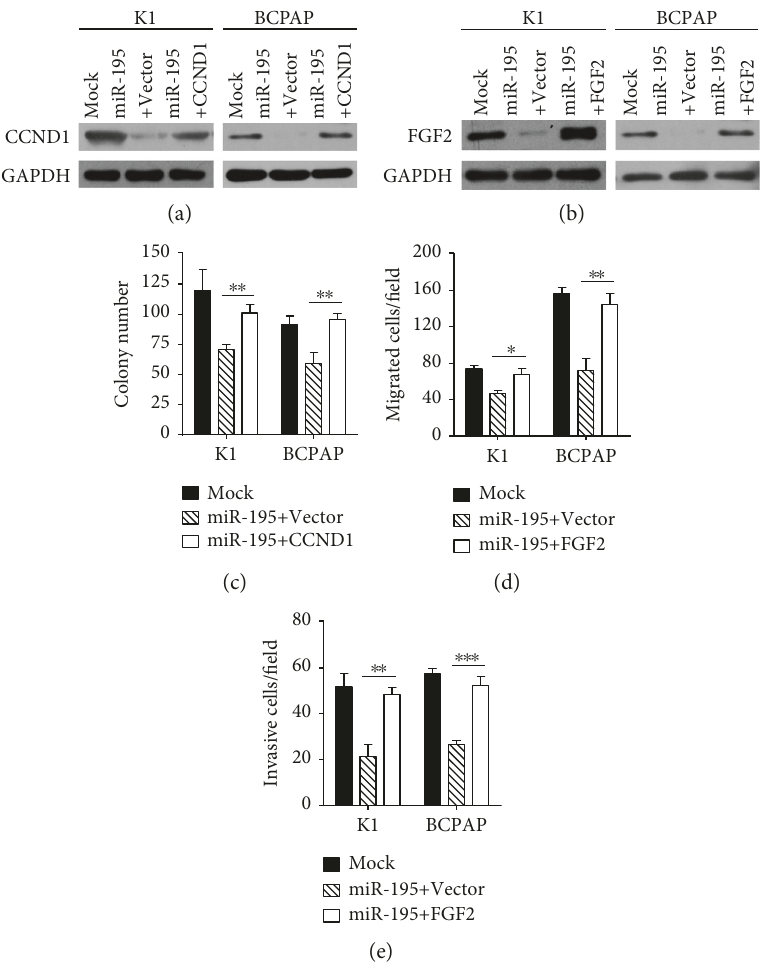
Figure 6: Overexpression of CCND1 or FGF2 can rescue the inhibitory function of miR-195 in PTC cells. (a, b) Ectopic expression of CCND1 and FGF2 were con fi rmed by Western blot. (c) Colony formation assays show that reexpression of CCND1 reverses the e ff ect of miR-195 on PTC cell proliferation. (d, e) Transwell migration and invasion assays indicate reexpression of FGF2 can antagonize the inhibitory e ff ects of miR-195 on PTC cell migration and invasion. ∗ P < 0 05 compared with the control group, ∗∗ P < 0 01 compared with the control group, and ∗∗∗ P < 0 001 compared with the control